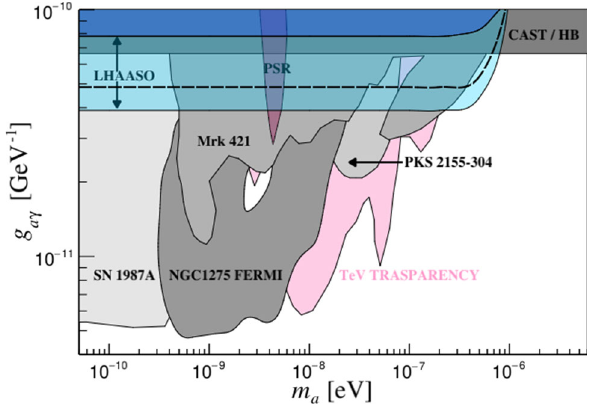
Fig. 10 Exclusionplotsintheparameterspace g a γ vsm a fromgamma- ray observations. The LHAASO bounds are in blue, where the range dark-light blue depends on the assumptions of the magnetic field in the source and on the initial gamma-ray spectrum, and the dashed line represents our benchmark case. For comparison it is shown also the CAST bound on solar ALPs [101], comparable with the stellar bound on helium-buring stars [102]. Other astrophysical bounds are in grey: namely the SN 1987A [103], the Fermi-LAT one on NGC 1275 [24], the H.E.S.S. bound on PKS 2155-304 [21], the Mrk 421 [104]. It is shown also the region hinted by the spectral modulations of pulsars (PSR) [105]. In magenta it is shown region where ALP conversions would affect the transparency of TeV photons